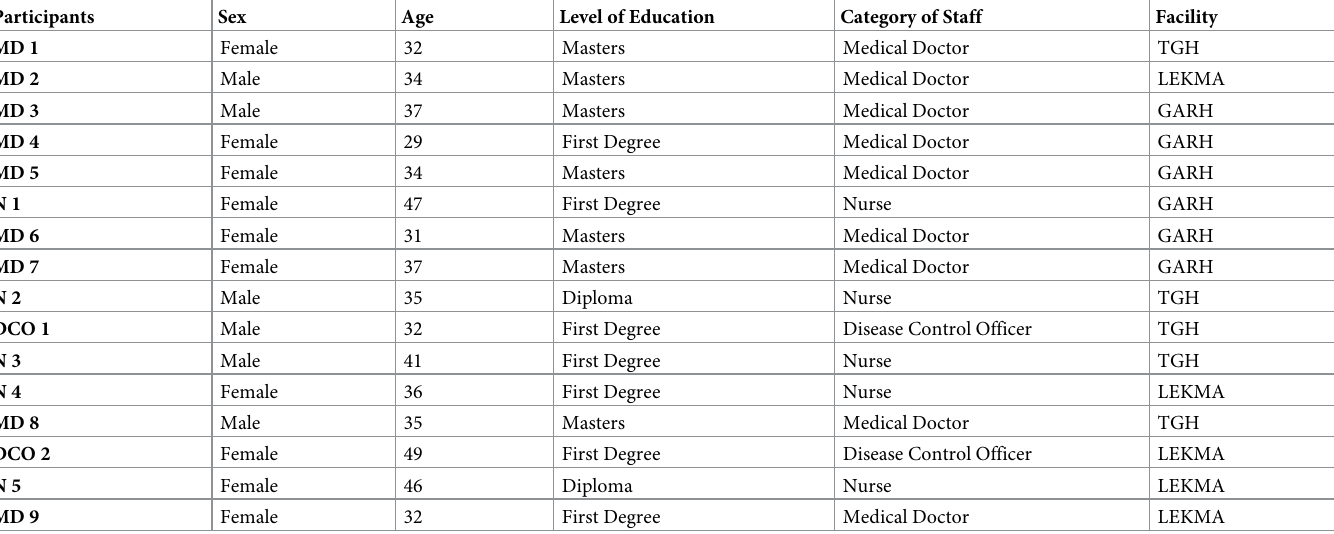
Table 1. Background characteristics of